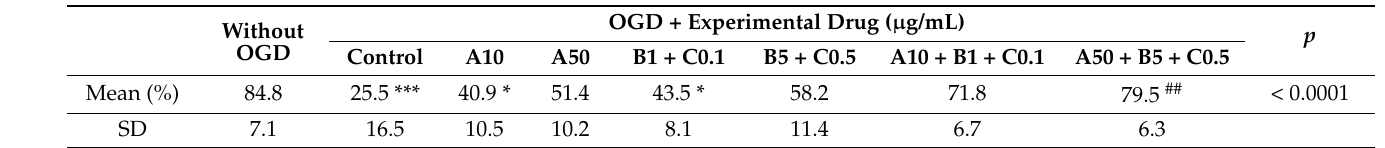
Table 4. Effects of the experimental drugs on OGD-induced cell death by cell count experiment in SH-SY5Y cells ( n = 5).